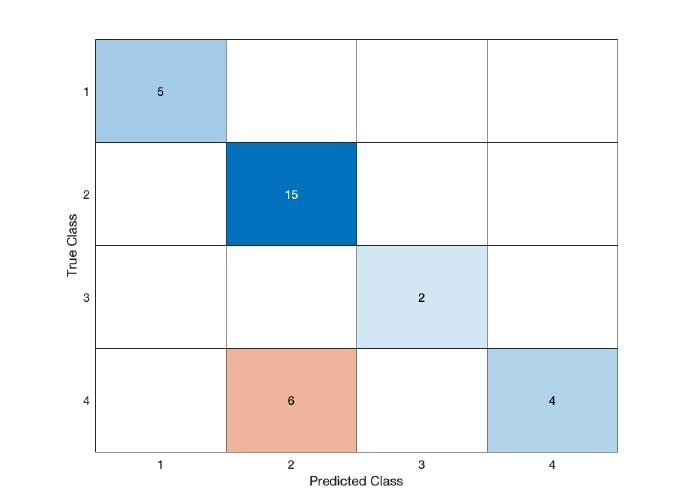
Figure 11. This figure shows the confusion matrix in the case of a subarea in which the lambda value is equal to 8%.